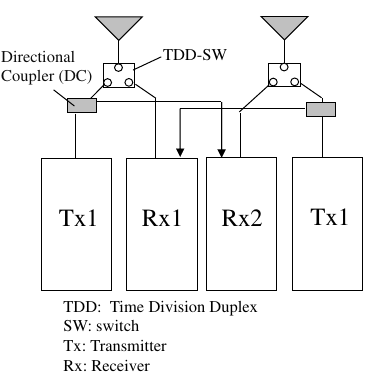
Figure 3. Basic circuit configuration of calibration method.